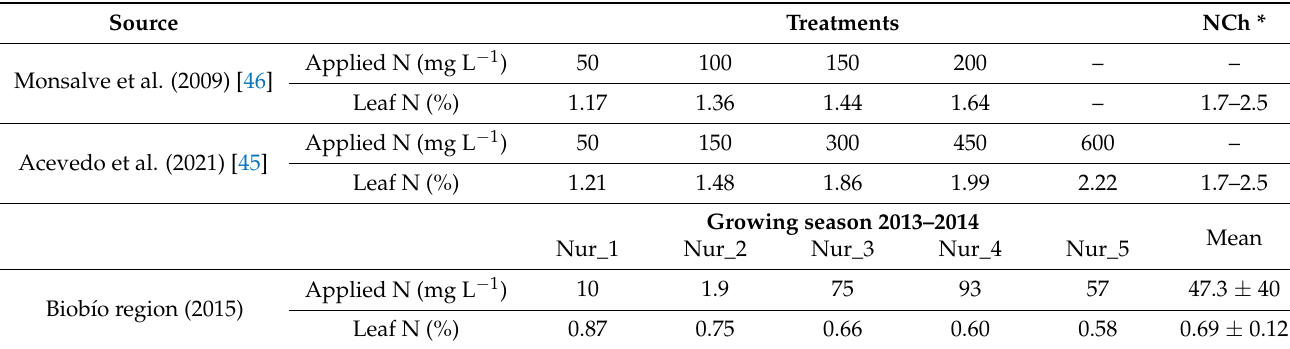
Table 3. Applied nitrogen concentrations (mg L − 1 ) and subsequent leaf N concentrations (%) on Eucalyptus globulus plants produced in hard-sided containers in research nurseries [45,46], which we observed in production nurseries in the Biob í o region during